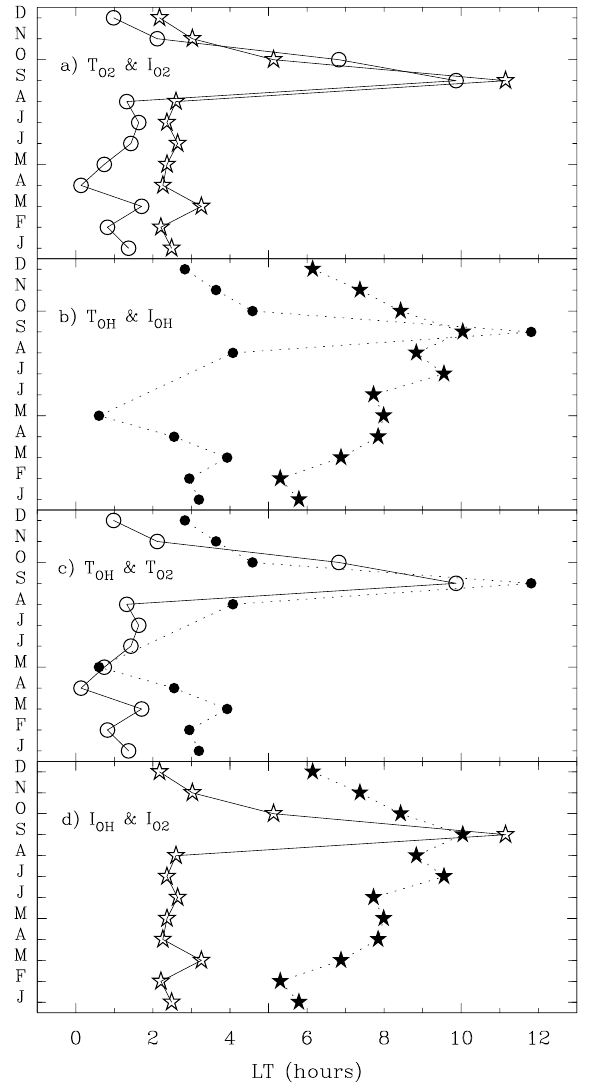
Fig. 3. Phases of maximum. (a) T O (c) T O and T OH . (d) I OH and I O 2 White star (solid line): I O star (dashed line): I OH